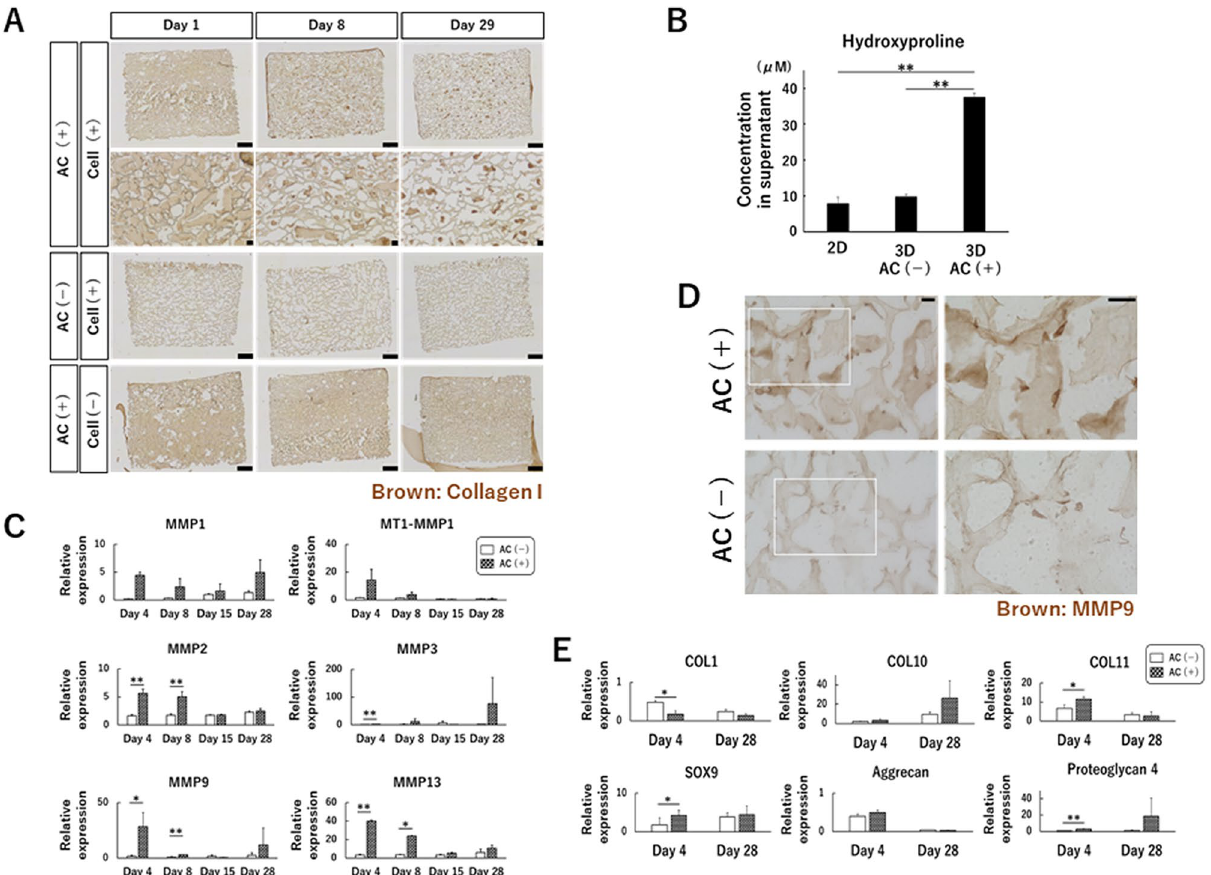
Figure 2. Atelocollagen gel impacts the expression of MMP family members. ( A ) Sections prepared from three different samples on three time points. AC(+), AC(−), and atelocollagen sponge without cells were immunostained with anti-type I collagen antibody. Scale bar: 200 μm. ( B ) The concentration of hydroxyproline in the supernatant was determined on day 3 of culture, as described in the Materials and Methods. ( C ) RT-qPCR analysis of MMPs. Normalized expression relative to 2D culture cells is shown. ( D ) Representative images of immunostaining using anti-MMP9 antibody in AC(−) and AC(+) samples. Right panels are magnifications of the square regions in the left panels. ( E ) Comparison of the expression of factors related to chondrocyte differentiation. ( C , E ) A representation of three independent experiments, each with three subjects and normalized expression relative to 2D culture cells at approximately 50–60% confluency (semi-confluent monolayers) is shown. * p < 0.05, ** p < culture and the AC(+) group, and there was no change in the AC(−) group. The change was particularly large in the AC(+) group, with MMP13 being significantly down-regulated in the presence of BTT3033, while MMP1 and MT-MMP1 were significantly up-regulated (Fig. 5D). As for the cell shape, cells in 3D culture were smaller than those in 2D culture (Fig. 6A,B) and cells in the AC(+) group cultured in the presence of BTT 3033 had a lower aspect ratio than cells cultured without BTT 3033 (Fig. 6A,C). α2β1 integrin affects the response to cyclic compressive loading stimulation in 3D cul‑ ture. Cell–ECM interactions are thought to play a role in the response to mechanical stimulation 20 . 3D cul- ture cells were subjected to cyclic compressive loading (CCL) stimulation using a bioreactor. First, we exam- ined the concentration of lactate dehydrogenase (LDH) in the culture supernatant as a marker of cytotoxicity (Fig. 7A). In the AC(−) group, the concentration of LDH after CCL was significantly higher than that before CCL. This difference was also observed in the presence of BTT 3033. In the AC(+) group, however, the concen-